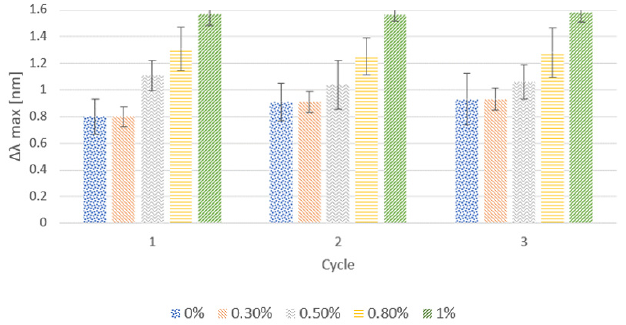
Figure 4. Δλ maximum for samples formulated with APG/CAPB 12 wt. % and different levels of the cationic polymer at room temperature and pH ~7.